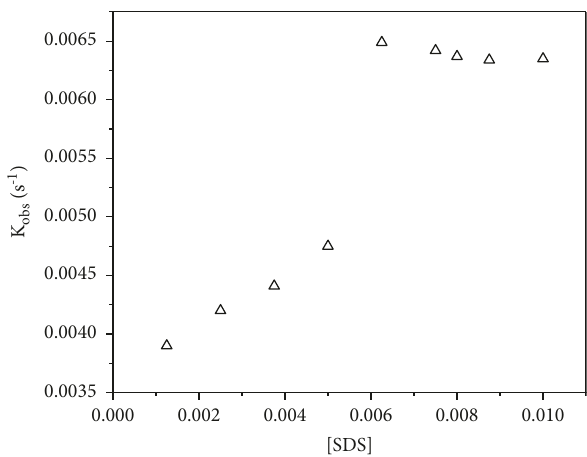
Figure 7: k obs vs. [SDS], at the following reaction conditions: [Maltose] � 0.030 moldm − 3 , [Ce (IV)] � 0.0030mol dm − 3 , and [H 2 SO 4 ] � 0.40mol dm − 3 at